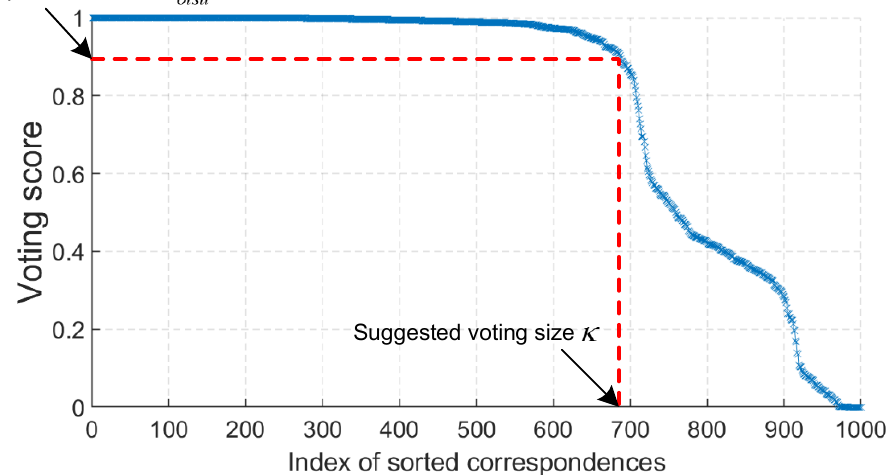
Figure 3. An adaptive strategy to determine the cardinality of the voting set. C initial is first sorted according to the voting scores at the i − 1th iteration; an adaptive threshold τ otsu is then computed based on Otsu’s thresholding method [41]; the number of correspondences whose voting scores are greater than τ otsu is defined as κ . The point cloud pair used to generate this figure is taken from the Bologna Dataset1 (BoD1) [42] dataset.